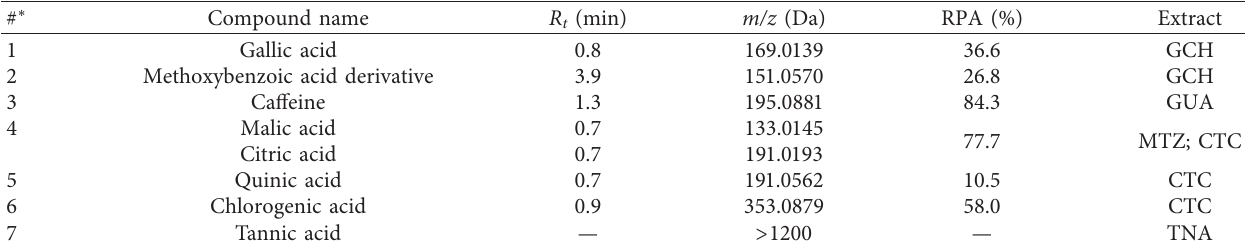
Table 3: Major compounds identified in plant extracts with UPLC/DAD-ESI/HRMS/MS.